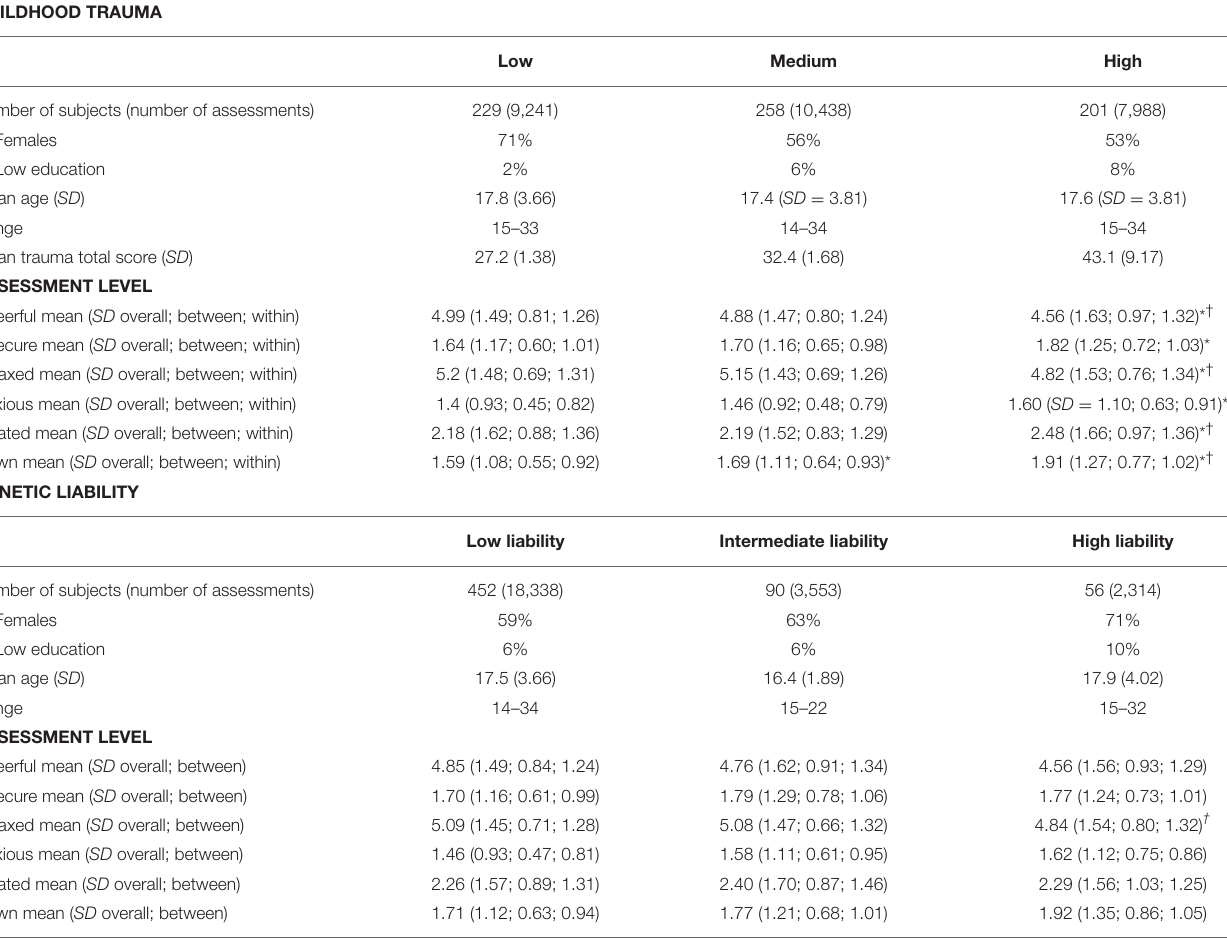
TABLE 1 | Descriptives stratified by childhood trauma and genetic